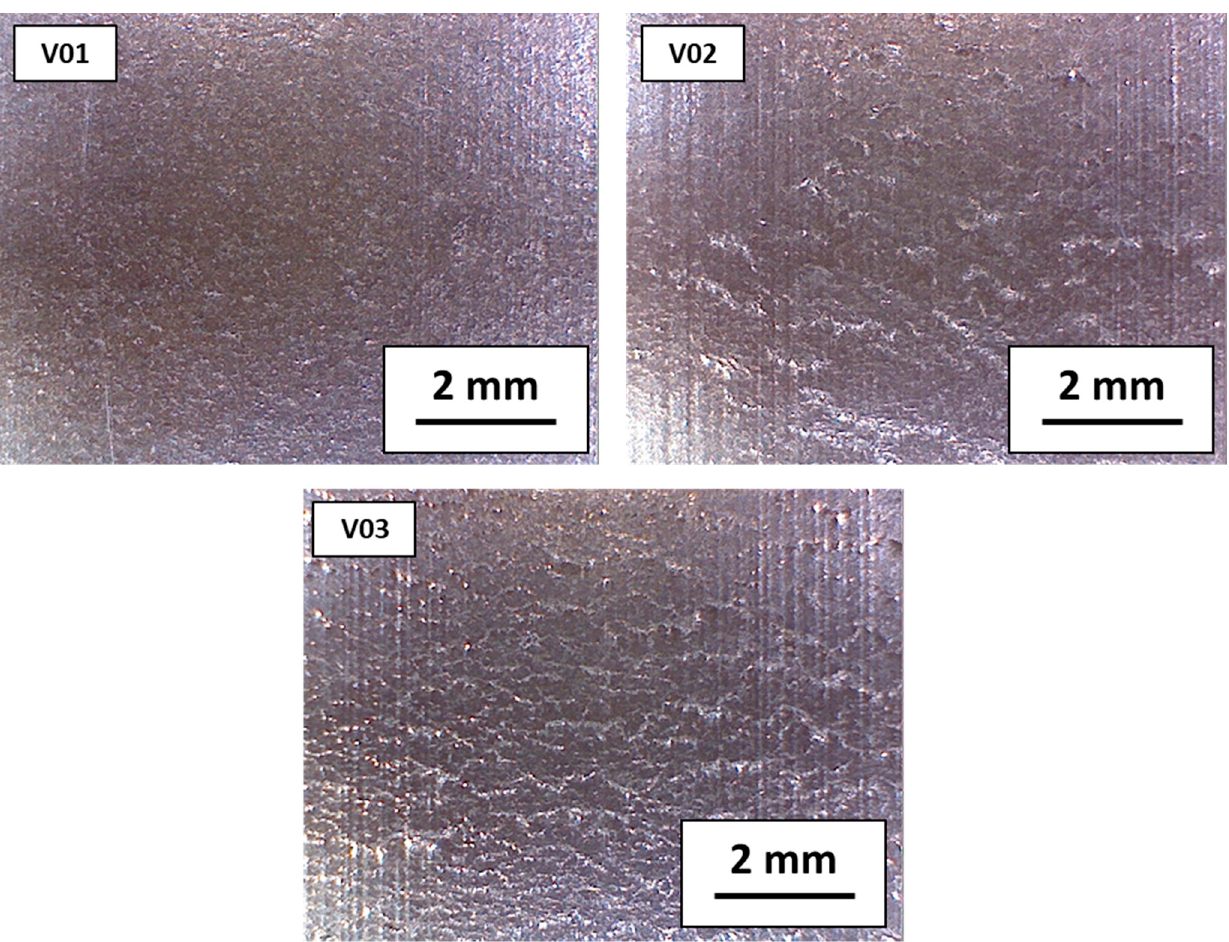
Figure 10. Running surfaces of the wheel discs at the end of the validation tests V01, V02 and V03.